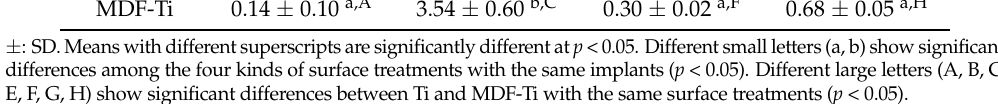
Table 3. Developed interfacial area ratio (surface deployment area rate) (Sdr) of surface-treated implants (%).